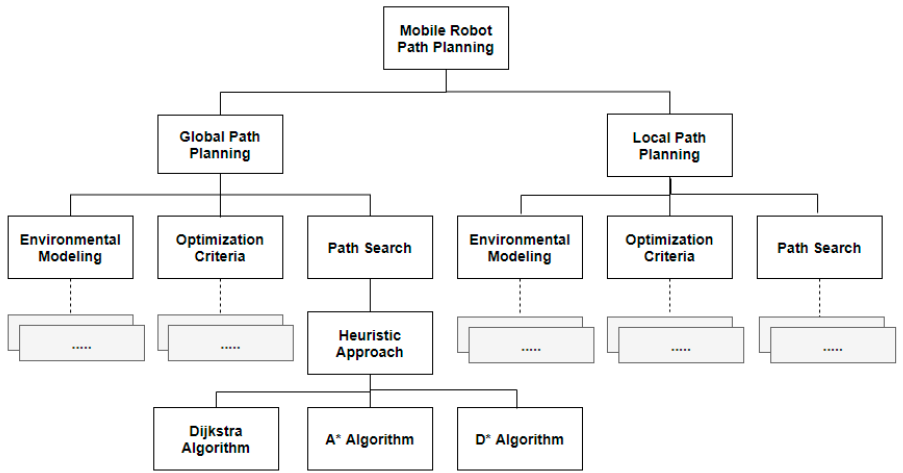
Figure 2. Development steps for global/local path optimization [13].